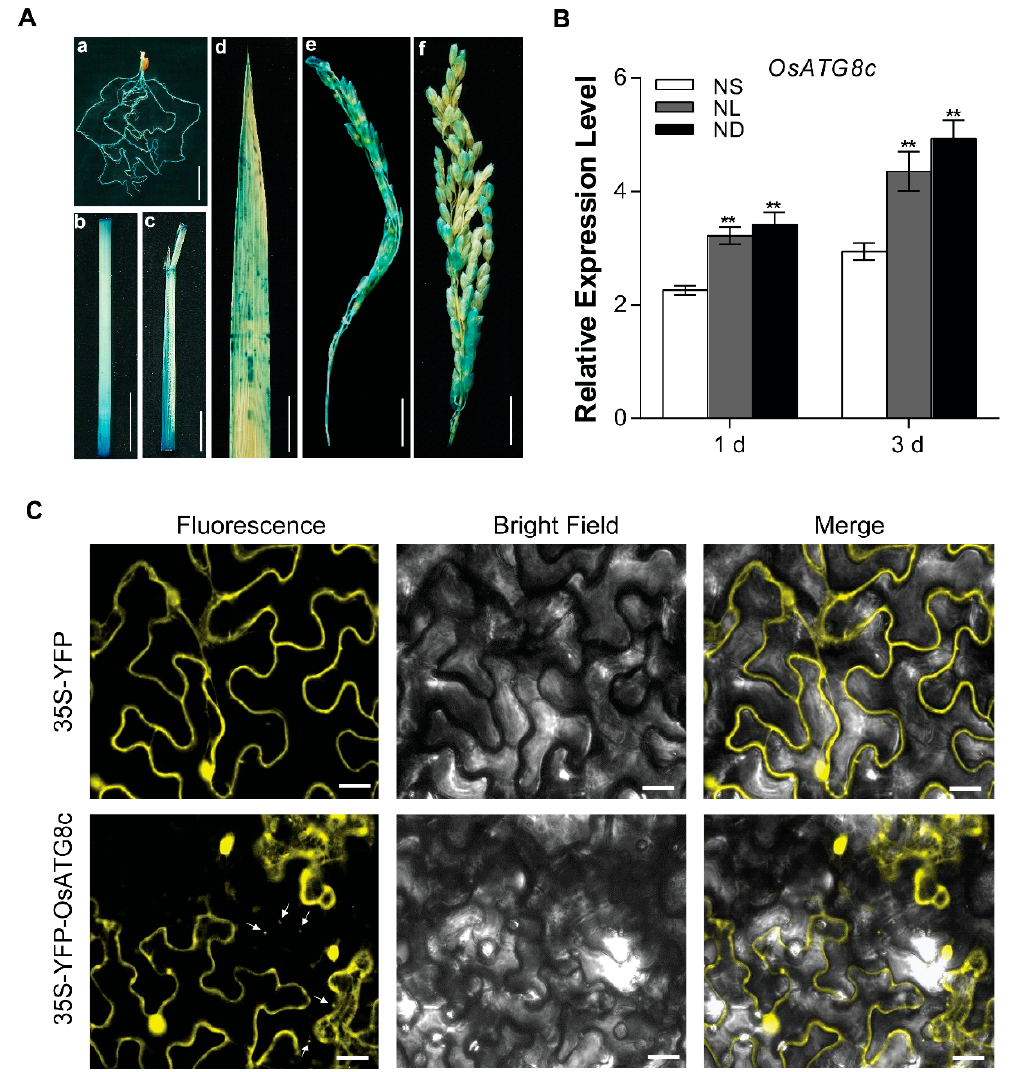
Figure 1. The expression patterns of the OsATG8c gene and protein subcellular localization of OsATG8c. ( A ) β -glucuronidase (GUS) histochemical staining of Pro OsATG8c -GUS transgenic rice. The tissues used for GUS staining included (a) root, (b) culm, (c) leaf sheath, (d) leaf blade, and panicle at the (e) booting stage and (f) grain filling stage. Scale bars: 2 cm in a–c and f, 1 cm in d and e. ( B ) The rice seedlings of Shennong9816 (SN9816) were cultured with sufficient nitrogen (N) (NS, 3.5 mM N) solution for 14 days and transferred to the same NS (3.5 mM N) solution as the control, low N (NL, 0.8 Mm N) solution and the deficient N (ND, 0 mM N) solution for 1 day and 3 days, respectively. When determining the expression of the OsATG8c gene in leaves, OsActin1 was used as an internal control. Values are means ± SD ( n = 10), ** p < 0.01 ( t -test). ( C ) Subcellular localization of OsATG8c in tobacco leaves. From left to right, the panels show the images of yellow fluorescent protein (YFP) fluorescence and the bright-field and the YFP fluorescence and bright-field overlap image, respectively. 35S-YFP was used as a control. The white arrowheads indicate the autophagic structures. Scale bar: 10 μ m.